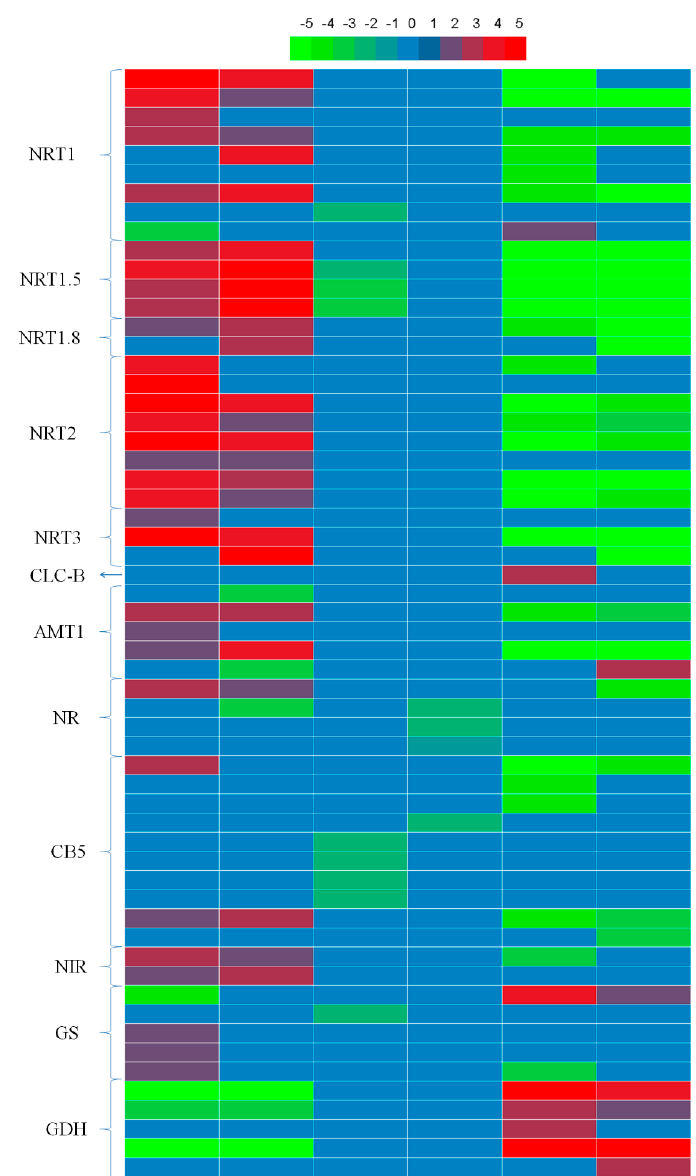
Figure 6. Heatmap showing the relative expression patterns of genes related to N metabolism between different comparison groups in 15 and 814. From left to right: 15-log 2 (NT / CK), 814-log 2 (NT / CK), 15-log 2 (AT / CK), 814-log 2 (AT / CK), 15-log 2 (NT / AT), and 814-log 2 (NT / AT). Colors indicate the relative differentialgeneexpression: green, downregulated; red, upregulated; andblue,